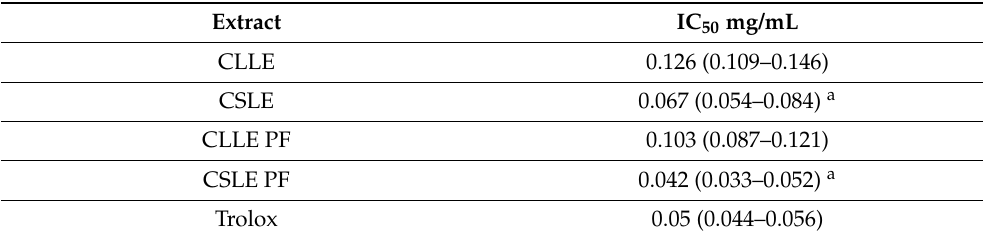
Figure 1. Inhibition of HClO-induced BSA degradation by C. laurifolius L. and C. salviifolius L. crude extracts and polyphenolic fractions. Image representative of three independent experiments. Dashed vertical black lines indicate removal of irrelevant lanes. Table 4. BSA protection against HClO-induced degradation by C. laurifolius L. and C. salviifolius L. crude extracts and their polyphenolic fractions.